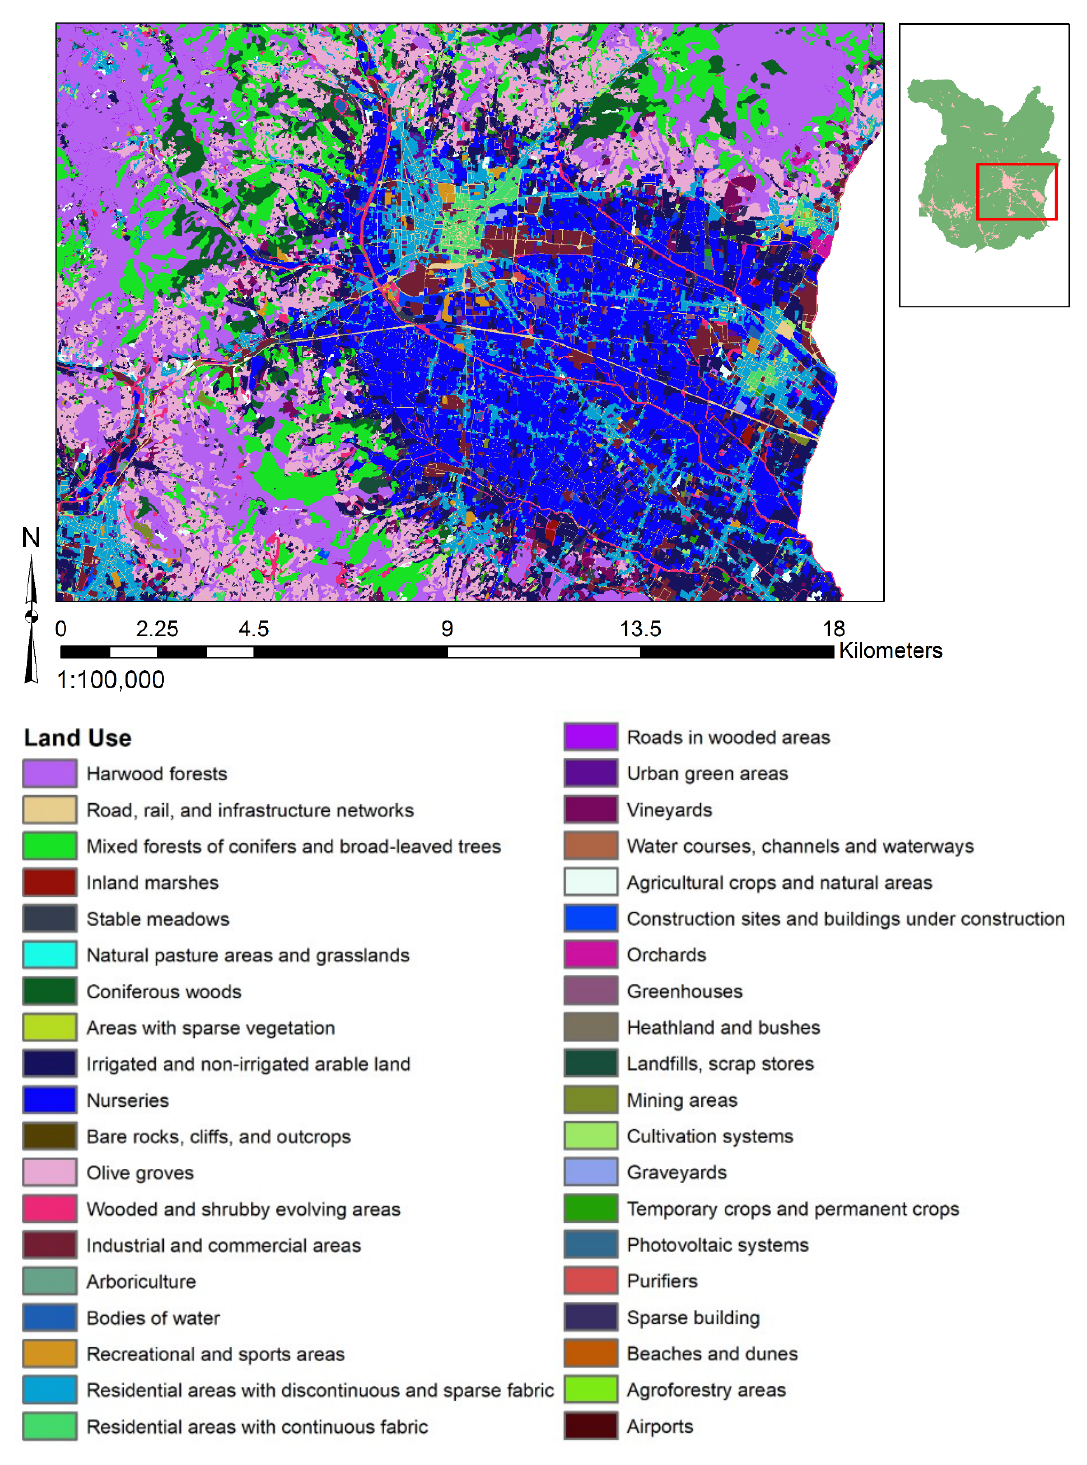
Figure 2. Land use classification of the city of Pistoia. Most of the nurseries (blue) are located around the city center.